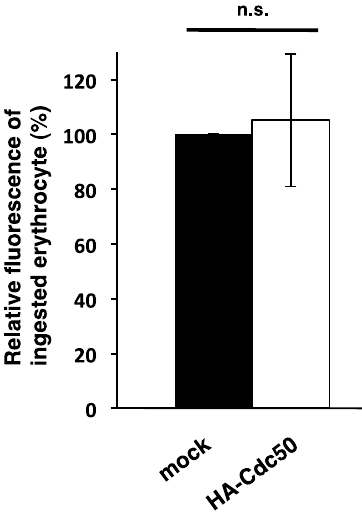
Figure A2. Effect of HA-EhCdc50 overexpression on erythrophagocytosis. Approximately 1 × 10 5 trophozoites of HA-EhCdc50 expressing and mock transformants were seeded on an 8-mm round wells slide glass. After removal of unattached trophozoites, 30 µ L of PKH26 red fluorescent-labeled (Sigma) erythrocytes at 10 7 cells/mL were added to the trophozoites to allow phagocytosis for 30 min. The samples were fixed and stained with an HA-antibody followed by visualization with anti-mouse Alexa 488 antibody. The fluoresce intensity of PKH26 incorporated by the HA-EhCdc50 expressing and mock tranformant trophozoites was measured on an LSM780 confocal microscope (Carl Zeiss) and analyzed with ZEN software (Carl Zeiss). Bar graph shows the means and standard deviations of three independent